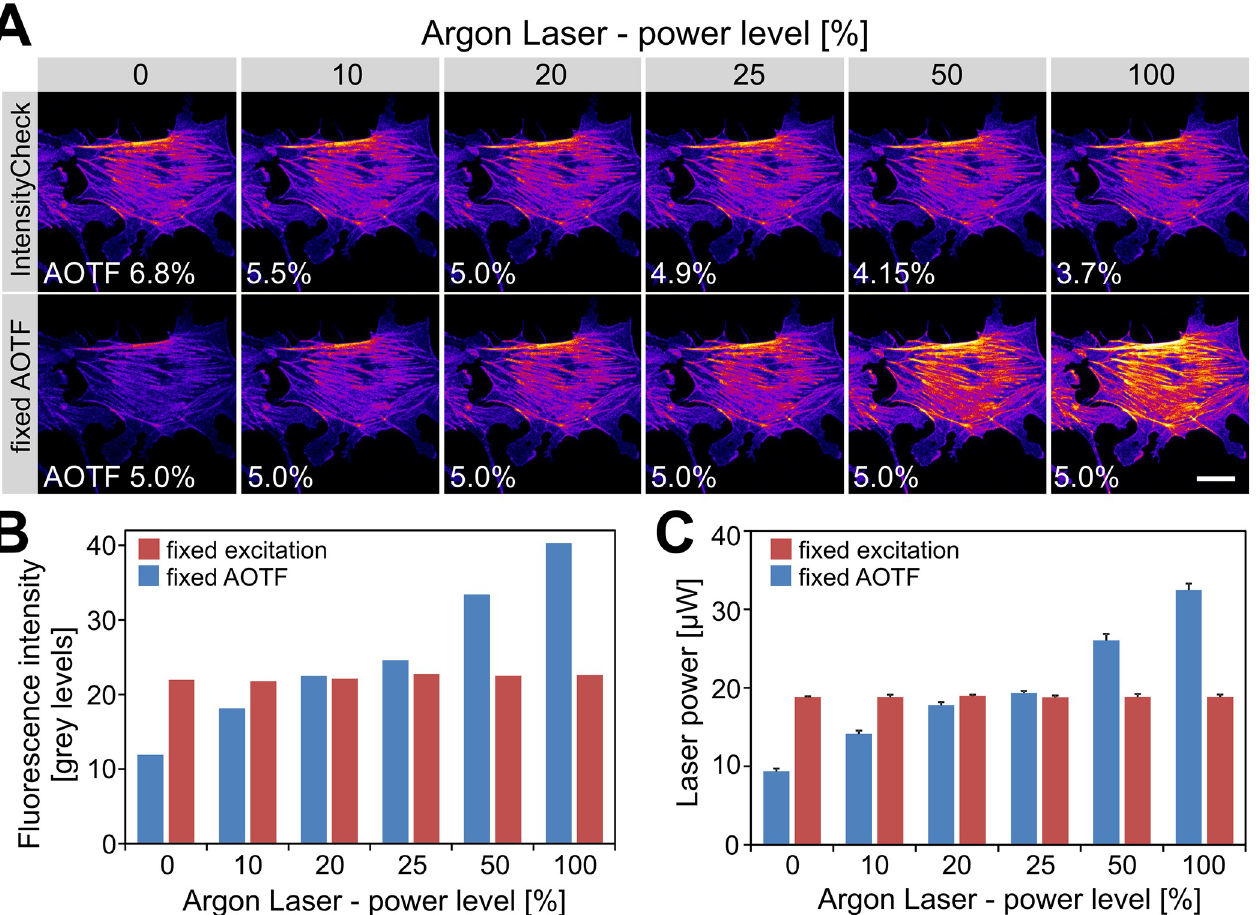
Fig 4. Using IntensityCheck to maintain constant sample illumination. (A) The upper row shows the constant sample fluorescence achieved with IntensityCheck despite ramping the Argon laser output “power levels” (488nm) from 0% to 100%. The actual AOTF settings are also displayed. The lower row for comparison with a fixed 5% AOTF setting shows an increase in fluorescence due to the rising laser output. Pseudo-colour representation of Alexa488-phalloidin labelled bovine endothelial cells. Scale bar: 20 μ m. (B) Quantification of the average image intensities from (A). (C) Measuring the actual laser power in the sample plane on the microscope stage in a separate experiment. The target for IntensityCheck here was to maintain 18.8 μ W (488nm) while increasing the laser output (0 to 100% power level). Achieved was 18.85 ± 0.25 μ W (n = 30; using theTCS34725 colour sensor). Shown are mean laser power and standard deviations of five attempts per laser power level to reach the target value with